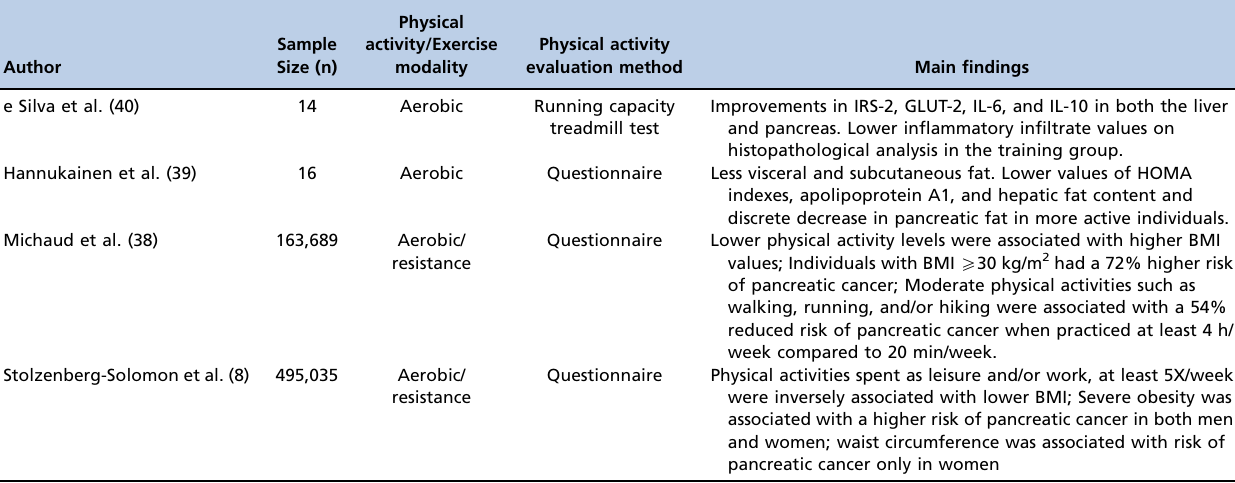
Table 2 - Characteristics of physical activity/exercise related to the features of fatty pancreas in the present review.